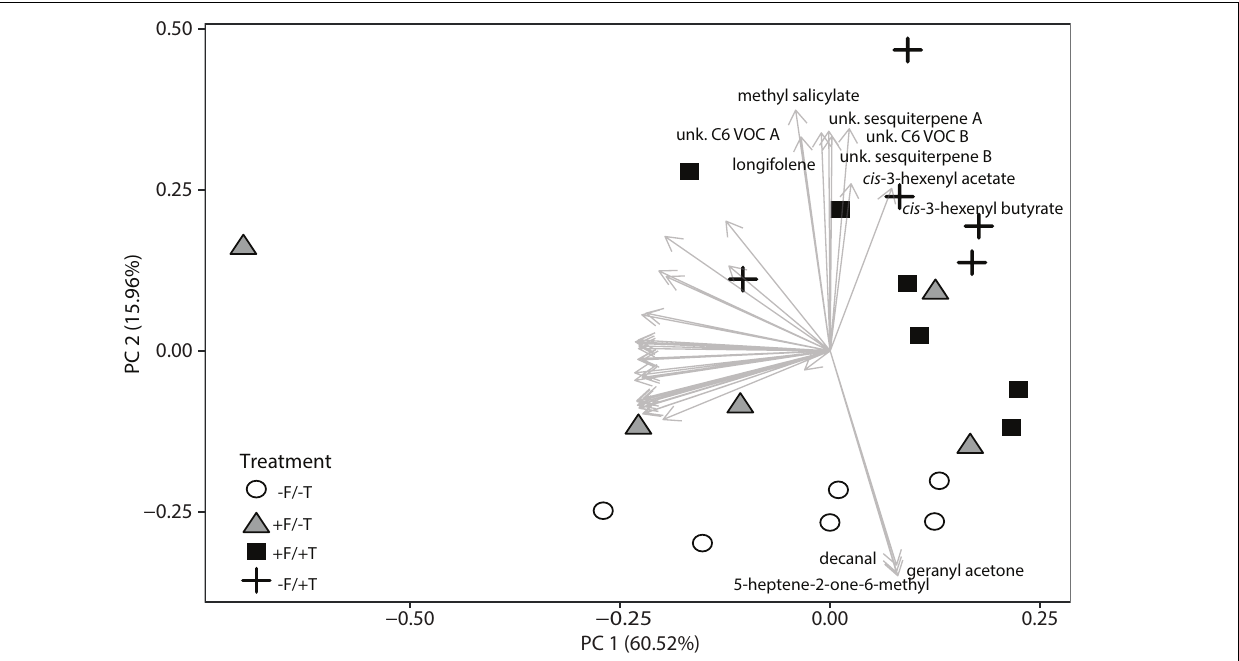
FIGURE 6 | Changes in volatile emissions from tomato plants colonized by the endophyte F. solani strain K (+F) and/or infested with spider mites ( T. urticae , +T). Principal Component Analysis of the autoscaled data of 41 selected volatiles as measured by TD-GC-MS 2 days after spider mite infestation. Analysis was performed on the average peak data. Symbols represent the different biological replicates within each treatment (control plants –F/–T, open circles; FsK - colonized plants +F/–T, gray triangles; FsK - colonized and spider mite infested plants +F/+T, black squares; and only spider mite infested plants –F/+T, black crosses, 5–6 biological replicates per treatment). Arrows represent the loadings of a single volatile compound. Volatiles that show high loading on PC 2, representing the FsK and spider mite treatment (treatment effect), are labeled by their names.